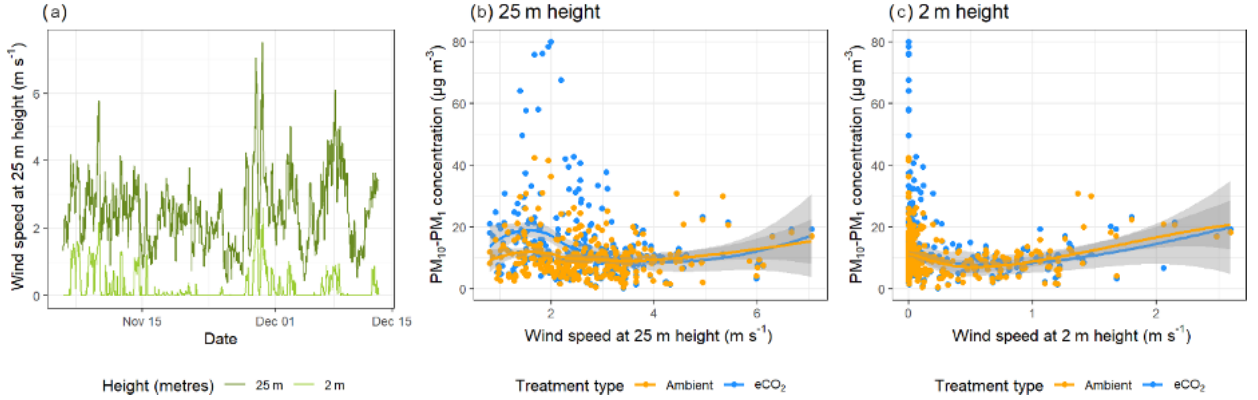
Figure 3. Wind speed and bioaerosol concentrations at the BIFoR FACE site in autumn 2018. Panel (a) shows the hourly average wind speeds above (25m height) and below (2m height) the canopy across the experimental duration. Wind speed data at 25m height are in dark green, and data from 2m height are in light green. Panel (b) compares hourly average PM 10 –PM 1 concentrations with hourly average wind speeds measured at 25m height, and panel (c) compares the same PM 10 –PM 1 concentrations using wind speeds measured at 2m height. Panels (b) and (c) both have loess lines of fit (Wickham et al., 2019), with data from ambient arrays (arrays 2, 3, and 5) in blue and data from e CO 2 arrays (arrays 1, 4, and 6) in